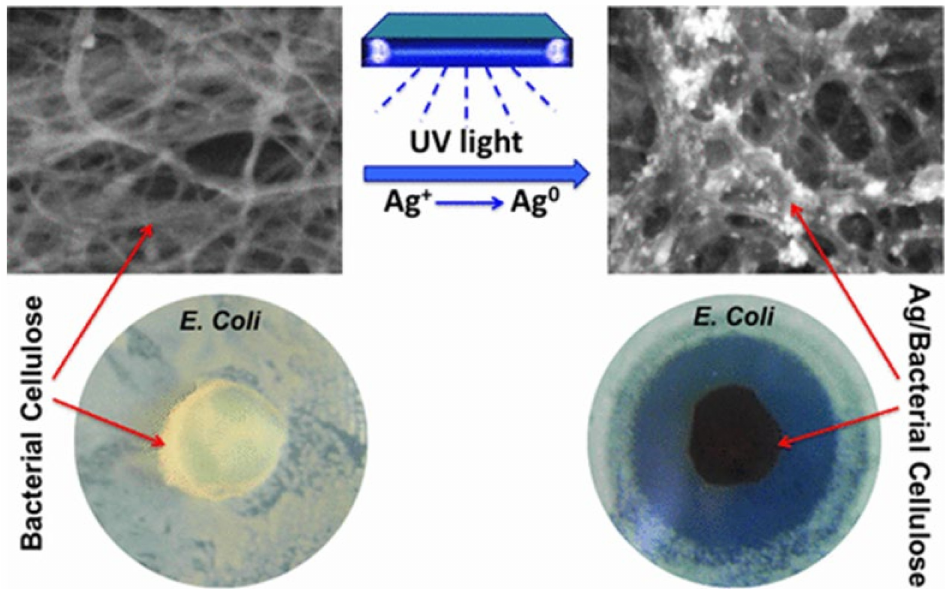
Figure 3. Formation of silver nanoparticles on the BC using UV light and its antimicrobial activity